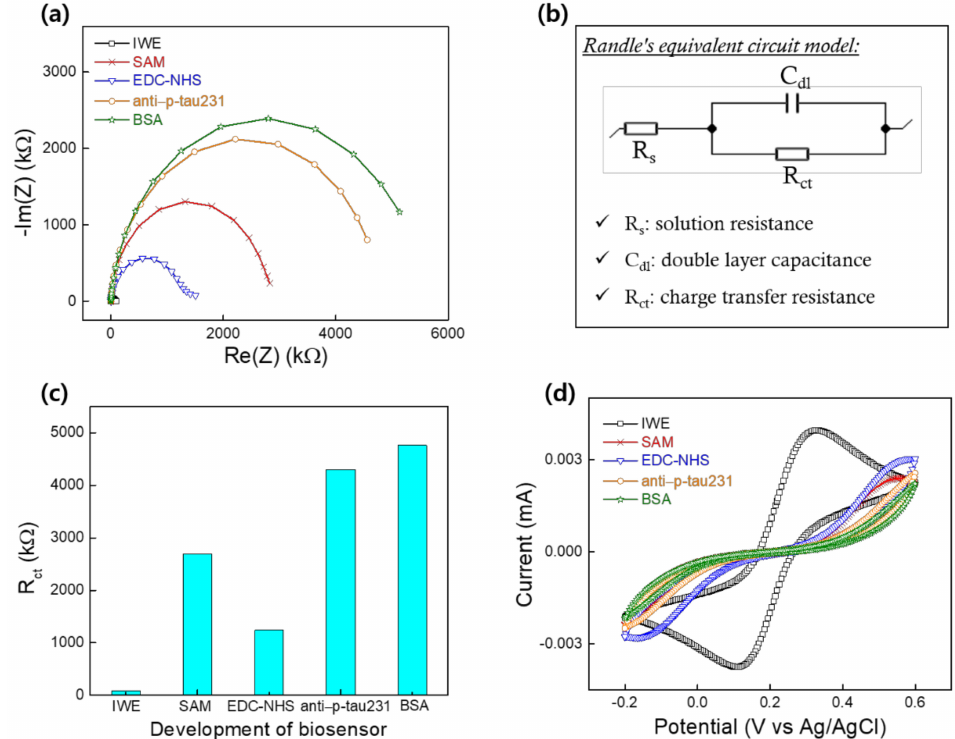
Figure 4. ( a ) Nyquist plots of the biosensor development at each step of IWE, SAM, EDC-NHS, anti–p-tau231, BSA in 1 mM [Fe(CN) 6 ] 3 − /4 − containing 0.1 M KCl; ( b ) Randle’s equivalent circuit model; ( c ) the fitted value R ct from Nyquist plots at each step of the biosensor development; ( d ) CV results at each step of the biosensor development in 1 mM [Fe(CN) 6 ] 3 − /4 − containing 0.1 M